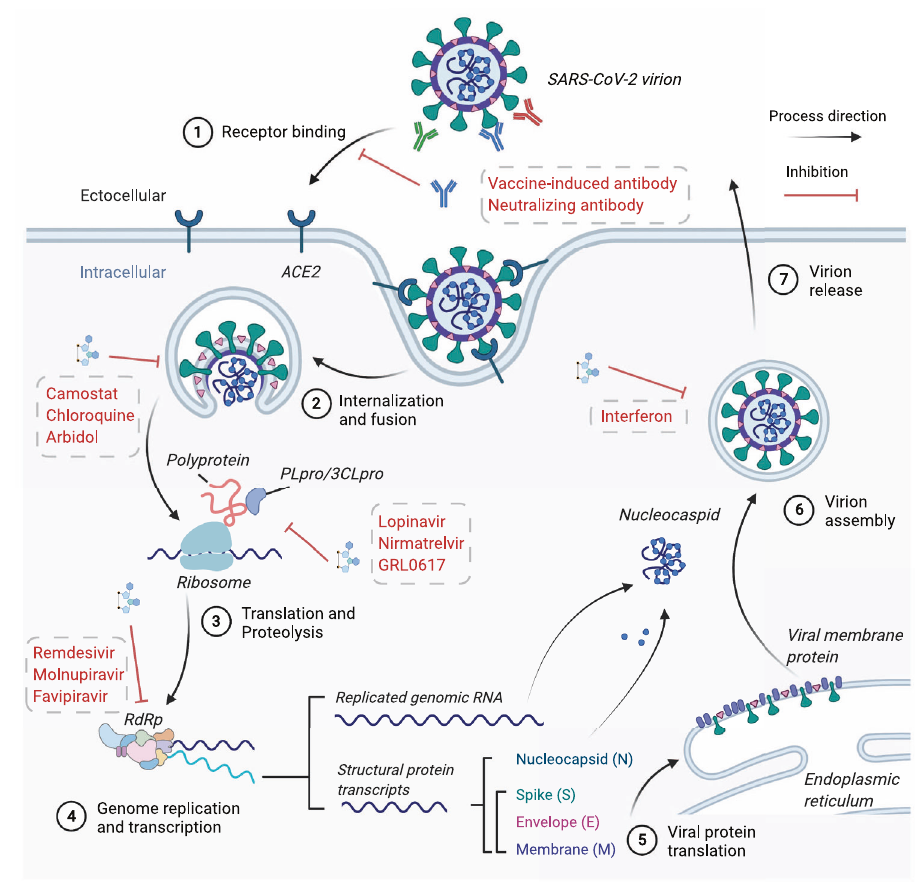
Fig. 5 Overview of SARS-CoV-2 infection and replication and the mechanism for anti-SARS-CoV-2 therapeutic agents. Step1: spike protein of SARS-CoV-2 binds to the host ACE2 to initiate viral attachment and endocytosis. The vaccine-induced antibody, neutralizing antibody, and ACE2-mimic protein could block this step. Step2: spike protein was cleaved by host TMPRSS2 to mediate spike protein conformation and viral fusion with the host membrane in an acidic endosomal environment. Small molecules such as Arbidol acted in this step. Step3: the released viral RNA genome is translated into polyproteins, and the translated product undergoes proteolysis by viral protein PLpro and 3CLpro to generate mature non-structural proteins and initiate viral replication. Protease inhibitors such as Nirmatrelvir target this step. Step4: the assembly of RNA-dependent RNA polymerase (RdRp) complex would start viral genome replication and transcription for structural proteins. RdRp inhibitors such as Remdesivir target this step. Step5: the transcripts for structural proteins would be translated further into the cytoplasm for N protein and in the endoplasmic reticulum for S, M, and E proteins. Step6: replicated RNA genome binds with N proteins to form nucleocapsid, and it would further assemble with other structural proteins in the membrane envelope. Immune modulators such as interferon act in this step. Step7: the assembled and enveloped virion is transported to the cell membrane and released. BioRender was used to generate this fi According to the binding epitopes, SARS-CoV-2 nAbs can be classi fi ed as RBD-targeted nAbs, NTD-targeted nAbs and other protein-targeted nAbs 172 – 177 and RBD-targeted nAbs accounted for